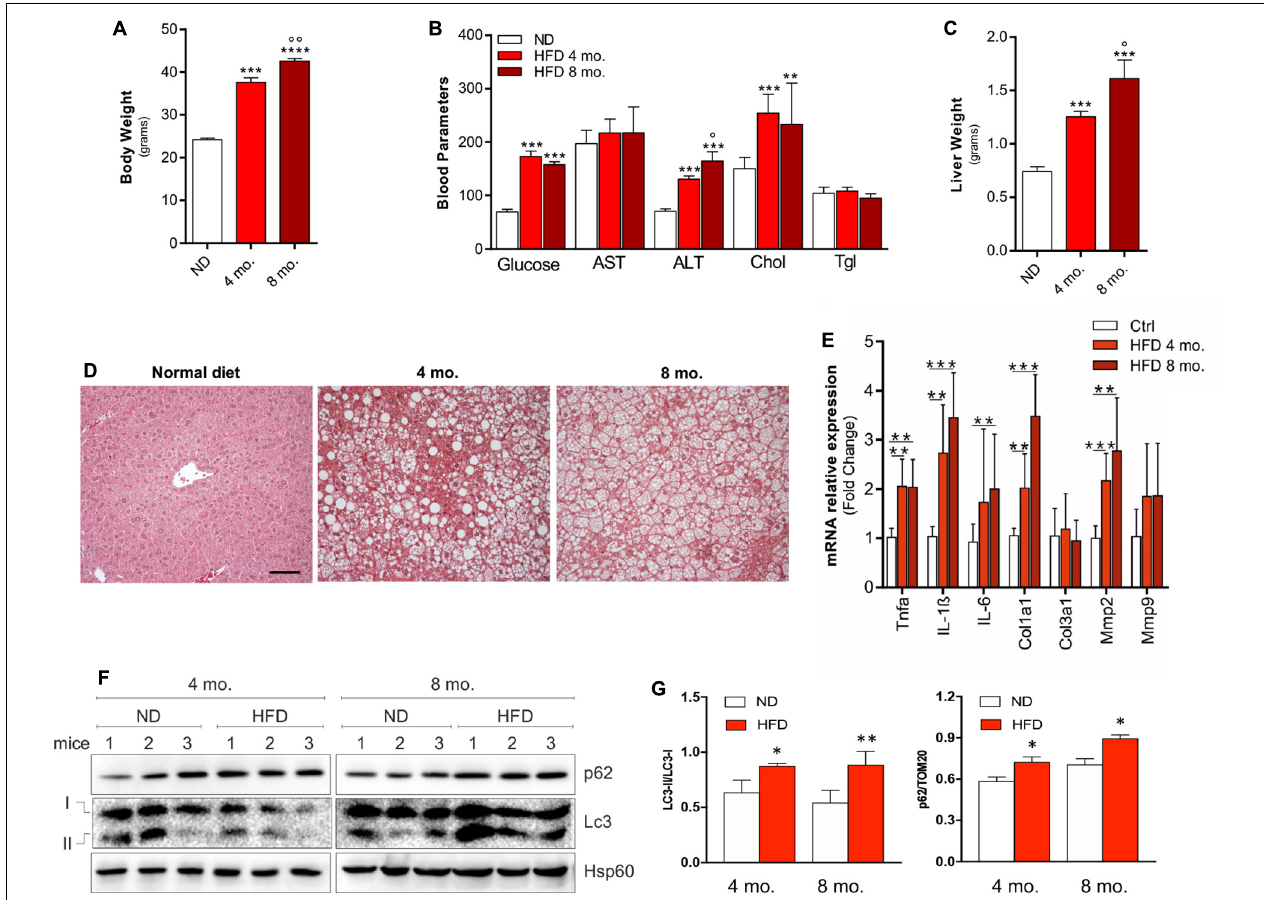
FIGURE 1 | C57BL/6J male mice were fed with high fat diet (HFD) or normal diet (ND) for 4 or 8 months. Increase of body weight (A) , alterations of biochemical parameters (B) , increase of liver mass (C) accompanied by histological steatosis (D) were observed in HFD mice compared to ND. The mRNA expression of inflammation- and tissue remodeling-related genes (E) and autophagy protein markers LC3-II/LC3-I ratio and p62/SQSTM1 (F) were progressively increased as demonstrated by densitometric analyses (G) , indicating autophagy inhibition. HSP60 was used as loading control and representative immunoblots are reported. * p < 0.05, ** p < 0.01, *** p < 0.001, **** p < 0.0001 vs. ND; ◦ p < 0.05, ◦◦ p < 0.01 vs. 4 mo. ( n = 6 mice per group). Original magnification: × 200. Calibration bar: 25 µ